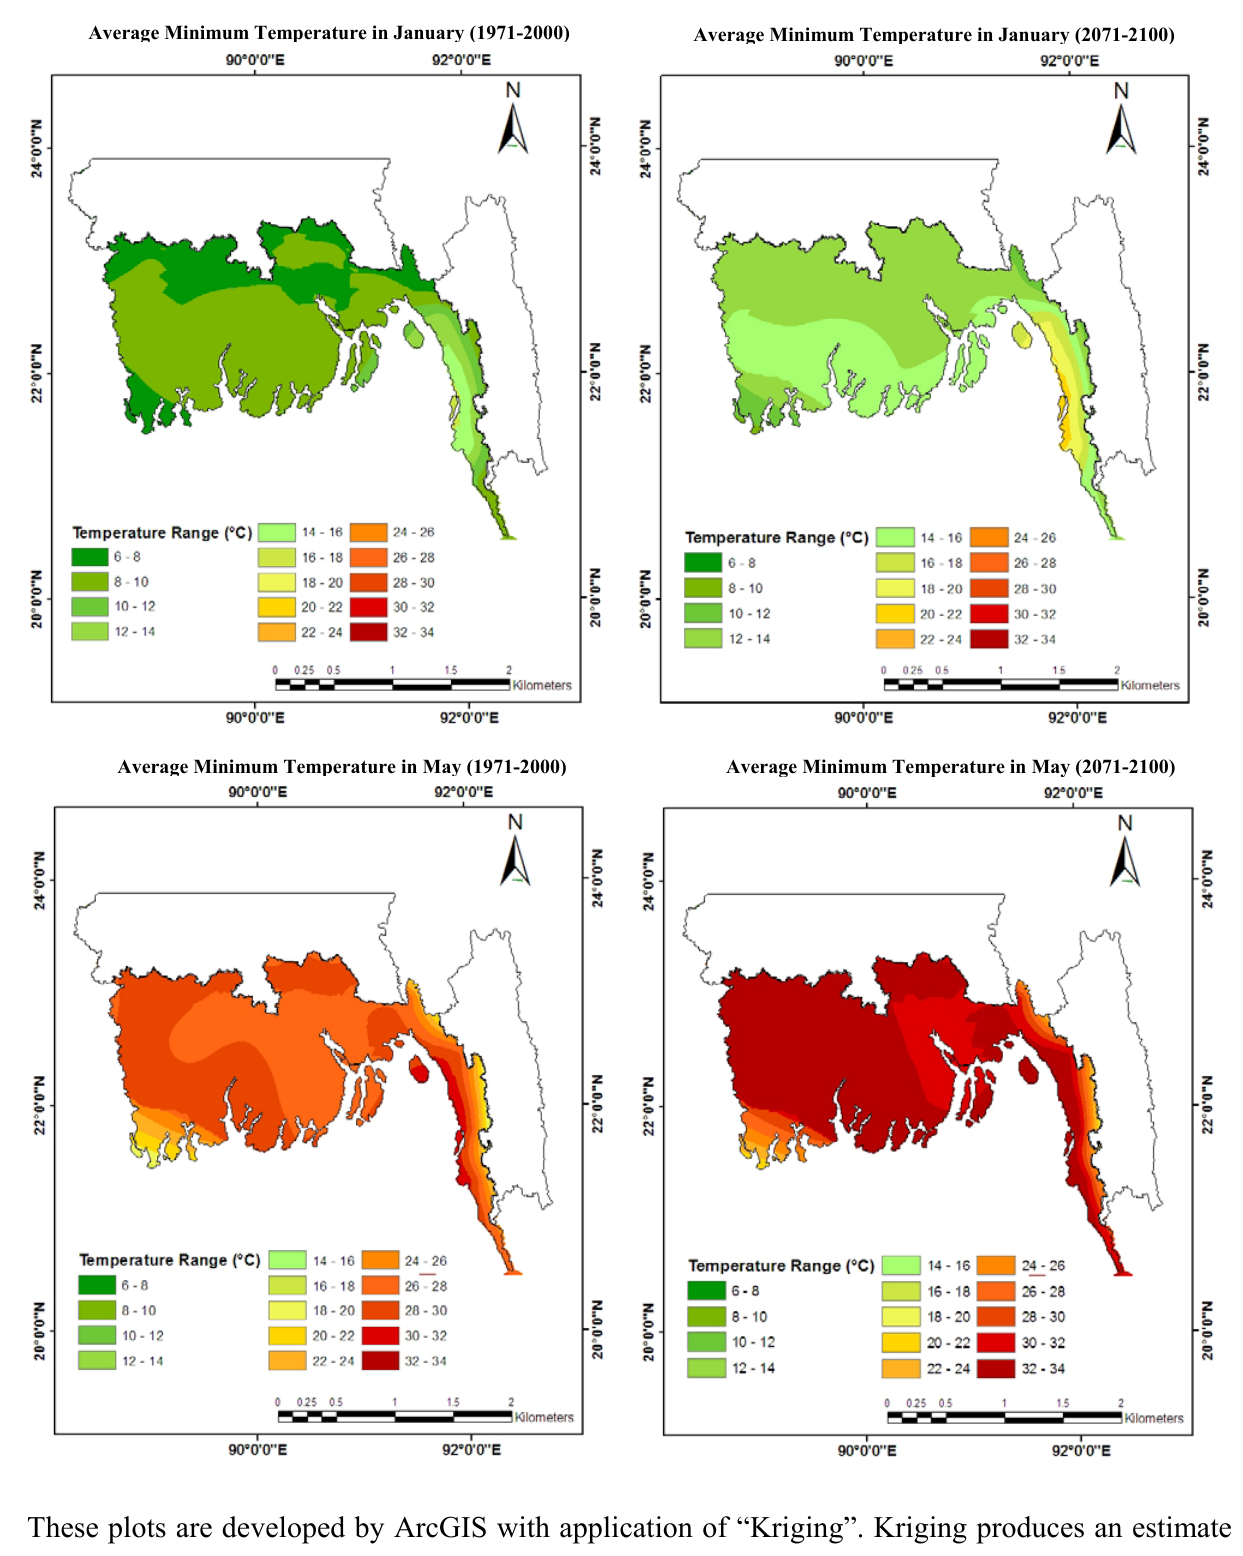
Figure 7. Spatial distribution of average minimum temperature in January and May (( top ) and ( bottom )): comparison between baseline (1971–2000) and simulated future